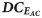
Comparison of the estimated value of DCEAC.